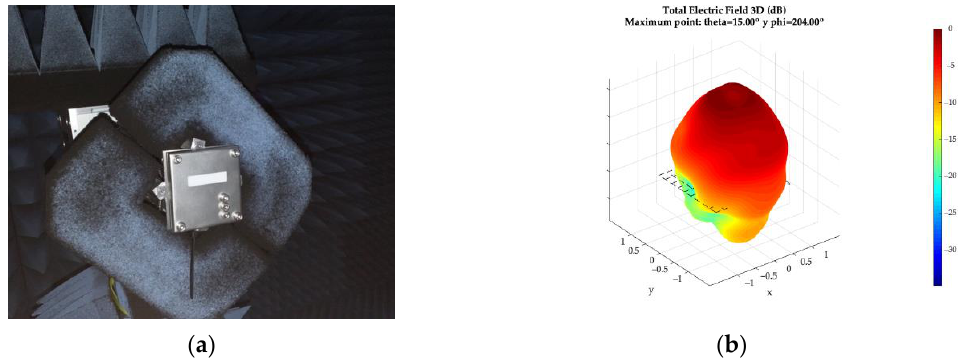
Figure 5. ( a ) Antenna performance measured in the anechoic chamber; ( b ) Measured total electric field.